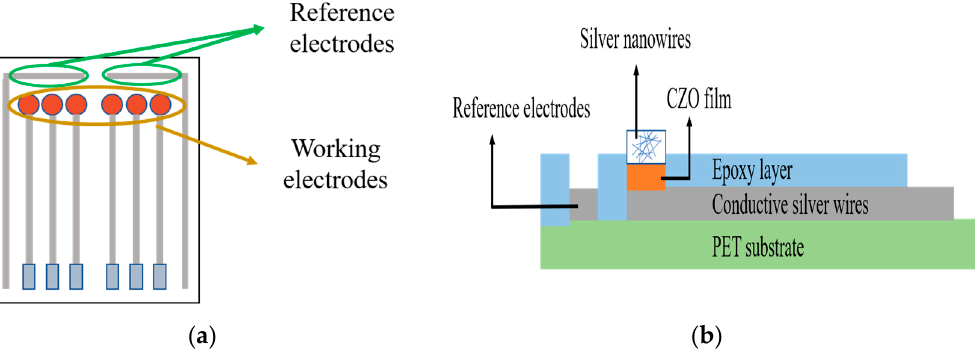
Figure 1. ( a ) Front view of the sensor, and ( b ) Side view of the sensor.